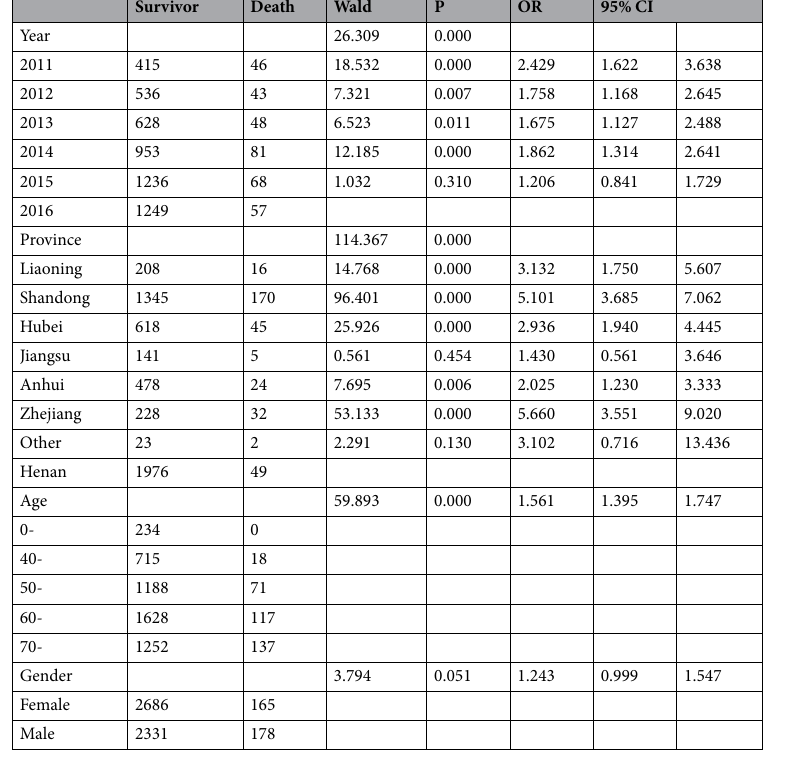
Table 3. Single variable analysis on factors associated with SFTS fatal outcome.